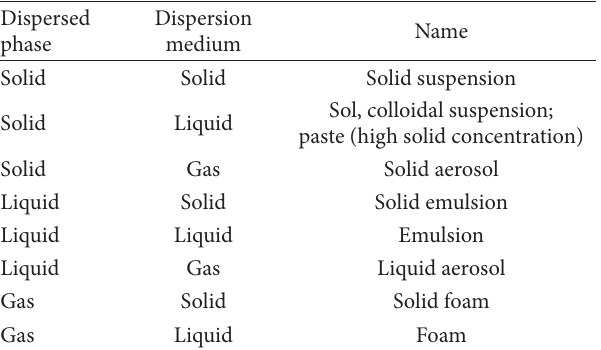
Table 2: Types of colloidal dispersion.